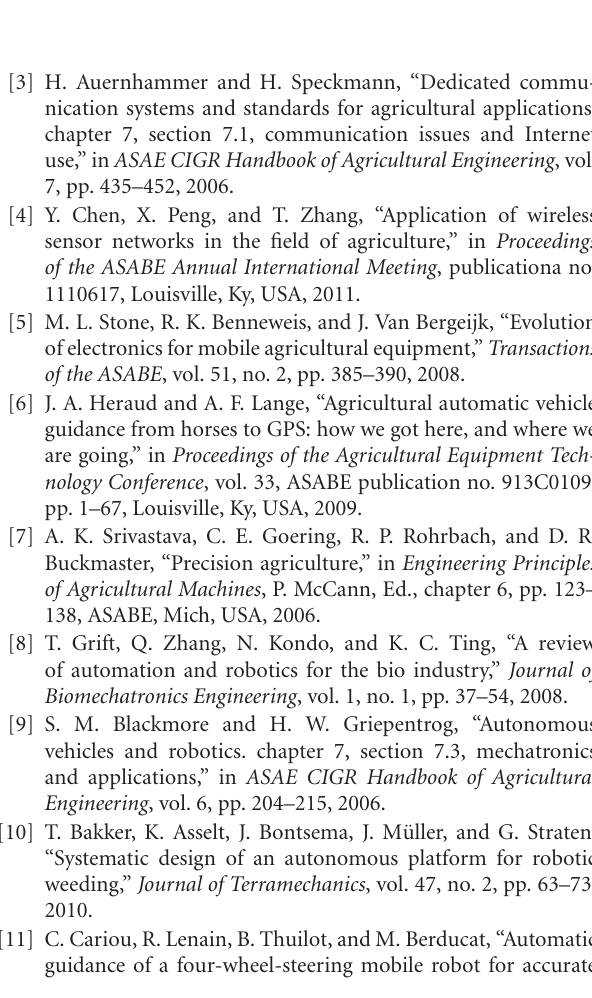
Figure 11: Back left wheel. (a) Wheel steering response comparing desired and real position. (b) Dynamic of PWM